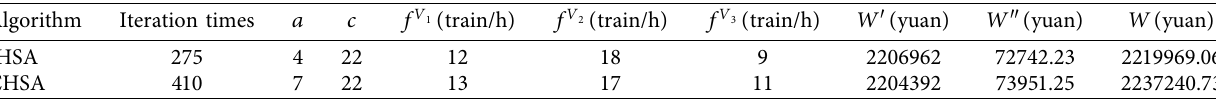
Table 9: Comparative analysis of IHSA and CHSA (the second set of parameters).